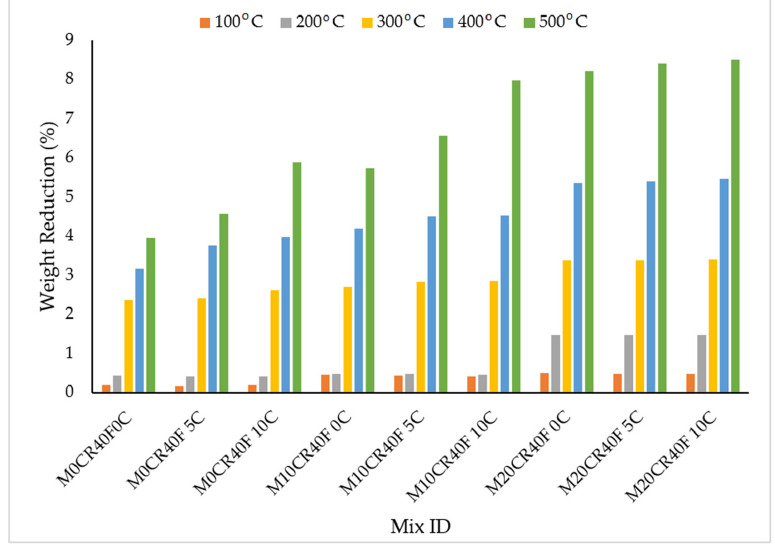
Figure 7. Effects of elevated temperature on weight of SCC mixes containing fly ash, CR, and